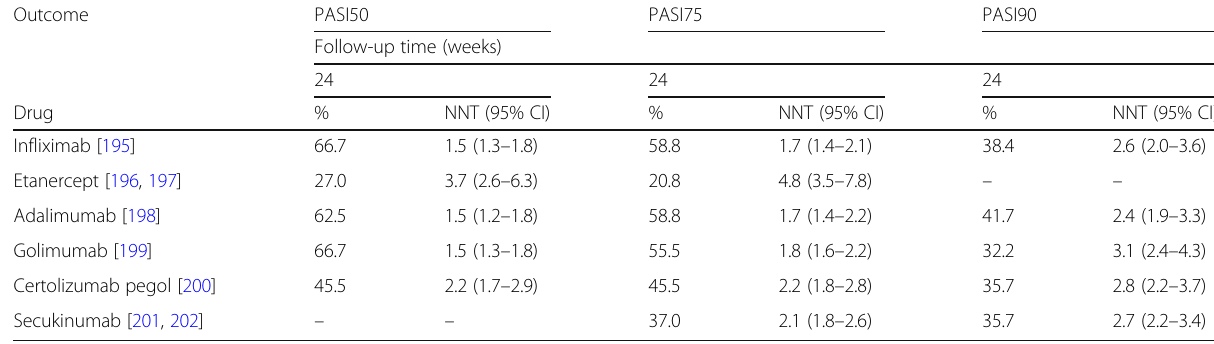
Table 7 Increase in the relative frequency (%), relative to placebo, in different outcomes, the corresponding number needed to treat (NNT) and 95% CIs calculated using a normal approximation. - Data were not available. Data from different studies were pooled when the same outcomes from the same treatments were available and when they referred to doses and/or regimens approved